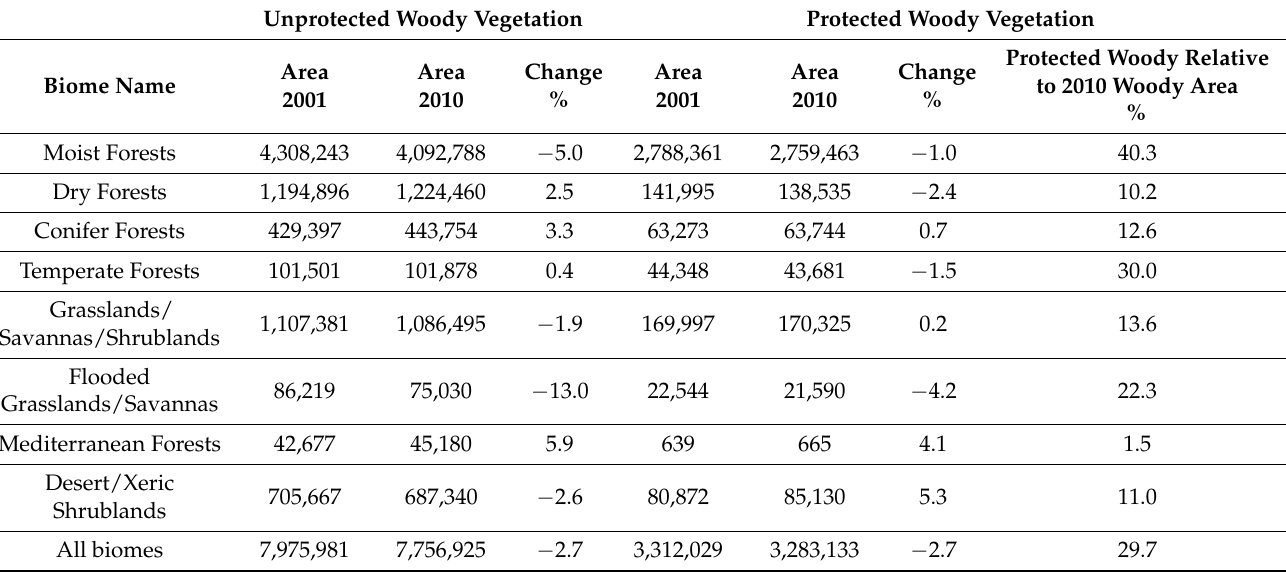
Table 5. Unprotected and protected woody vegetation change in LAC 2001–2010 by